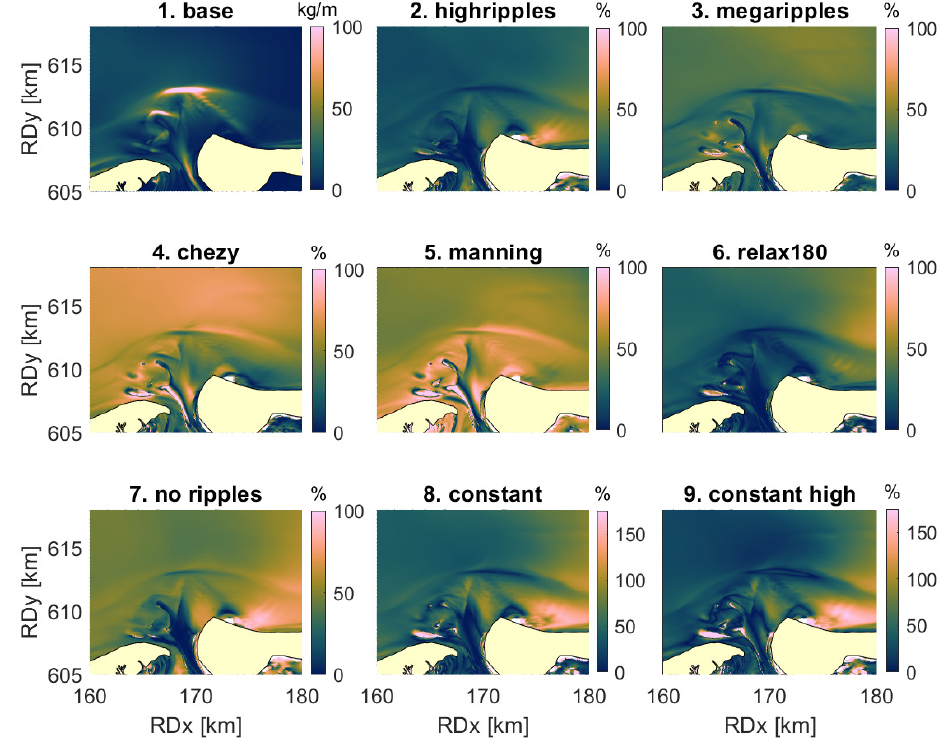
Figure 13. Time-integrated suspended load transport q s during the storm (1), and absolute relative difference in q s of all other scenarios with the base scenario during the storm